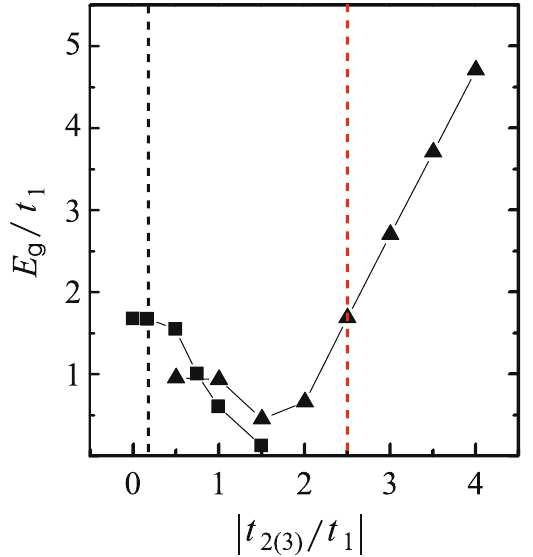
Figure 11. Gap values E g of 5a-Q1D-PNR as functions of | t 2 / t 1 | (triangle labelled line) and ( t 3 / t 1 ) (square labelled line). The nominal parameters are | t 2 / t 1 | = 2.5 and t 3 / t 1 = 0.17.